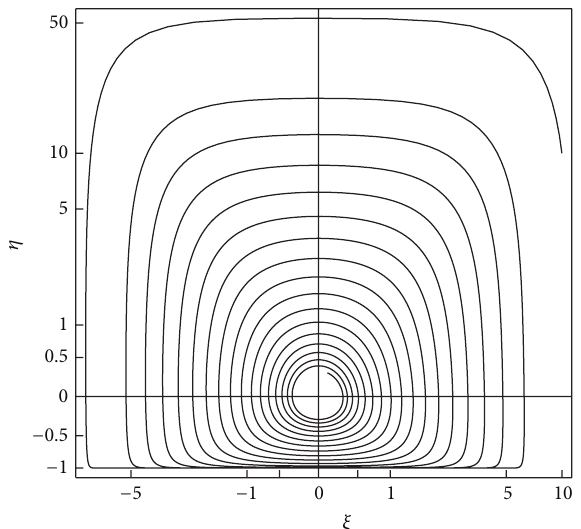
Figure 2: Phase-plane trajectory of the weakly perturbed Hamil- tonian system (13) for 𝛾 = 1.19375 , 𝜀 = 0.727273 × 10 −3 , and 𝜇 = 0.157107 . Near the equilibrium the oscillations are almost